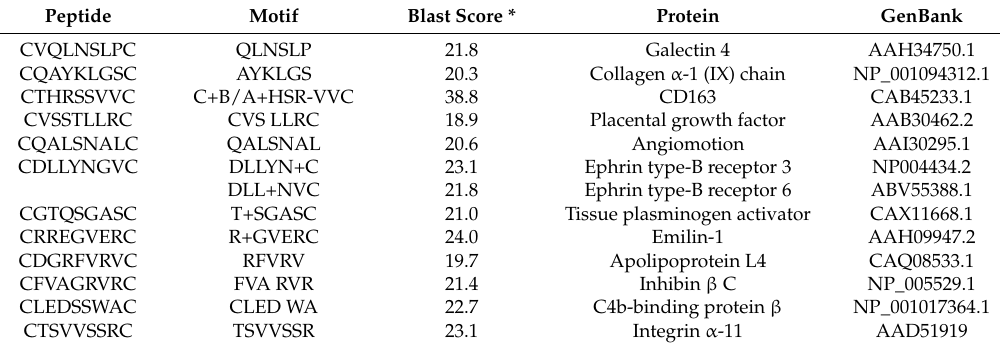
Table 2. Human homolog for select atheroma binding peptides.